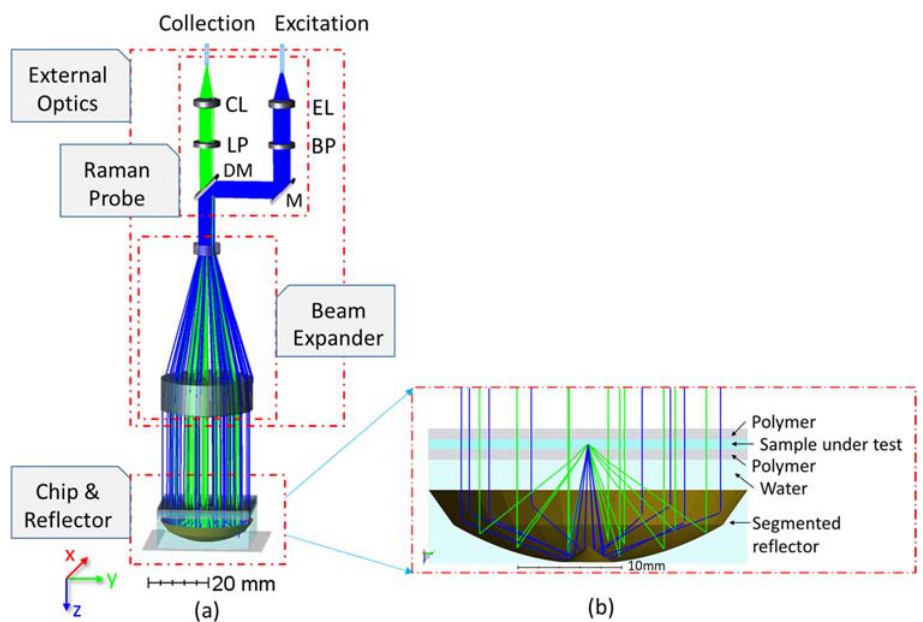
Figure 2. Non-sequential simulation in OpticStudio. ( a ) Overall layout, and ( b ) the microfluidic chip Figure 2. Non ‐ sequential simulation in OpticStudio. ( a ) Overall layout, and ( b ) the and segmented reflector. The blue rays and green rays refer to the excitation light and Raman light microfluidic chip and segmented reflector. The blue rays and green rays refer to the respectively. (EL: Excitation lens; CL: Collection lens; BP: Band-pass filter; M: Mirror; LP: Long-pass excitation light and Raman light respectively. (EL: Excitation lens; CL: Collection lens; BP: filter; DM: Dichroic Band ‐ pass filter; M: Mirror; LP: Long ‐ pass filter; DM: Dichroic mirror).